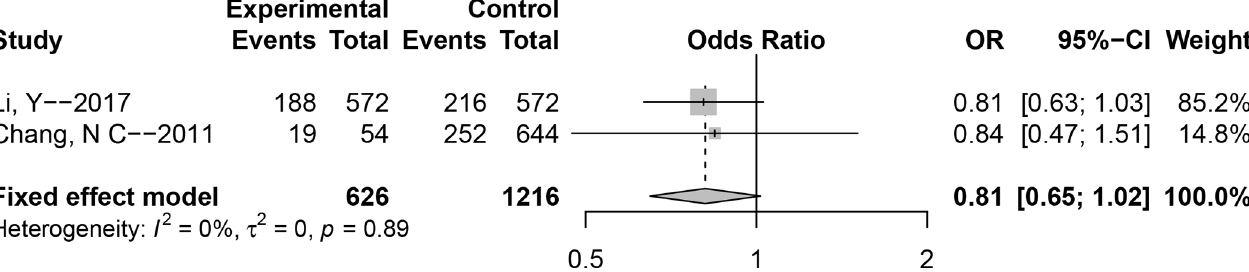
Fig 4. Forest plot of association between polymorphism rs2075800 and noise-induced hearing loss (NIHL) (Allele model: T versus C).